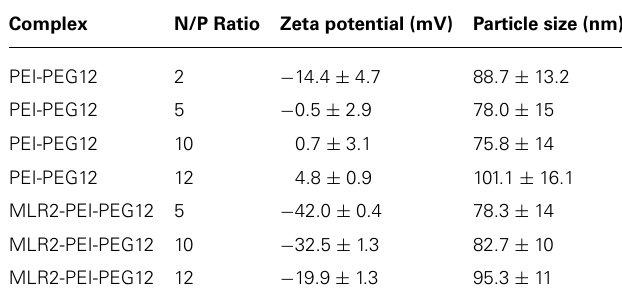
Table 1 | Size and zeta potential of